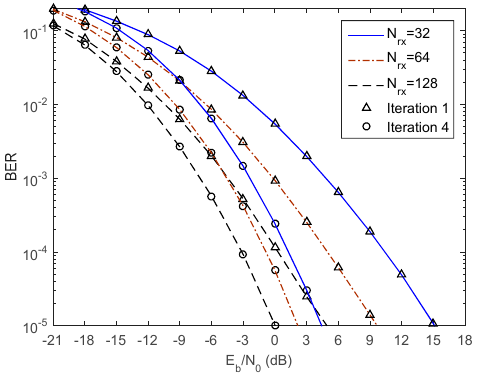
di ff erent number of users U = N RF rx .